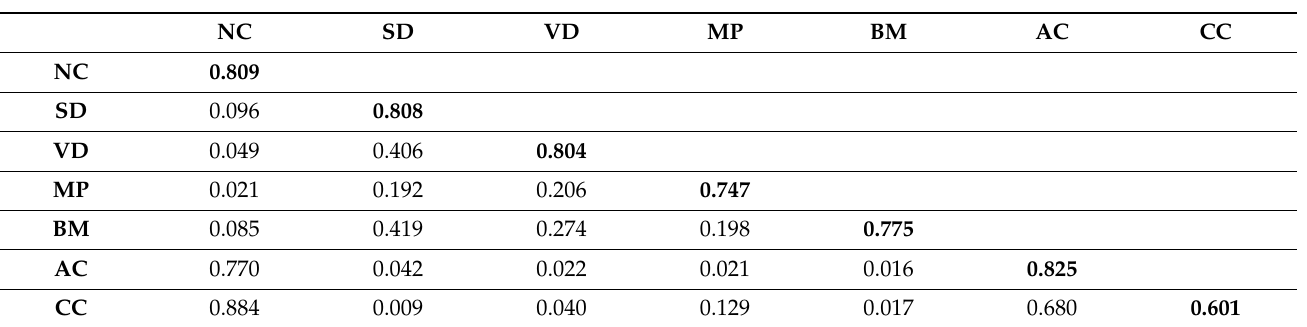
Table 4. Discriminant Validity.